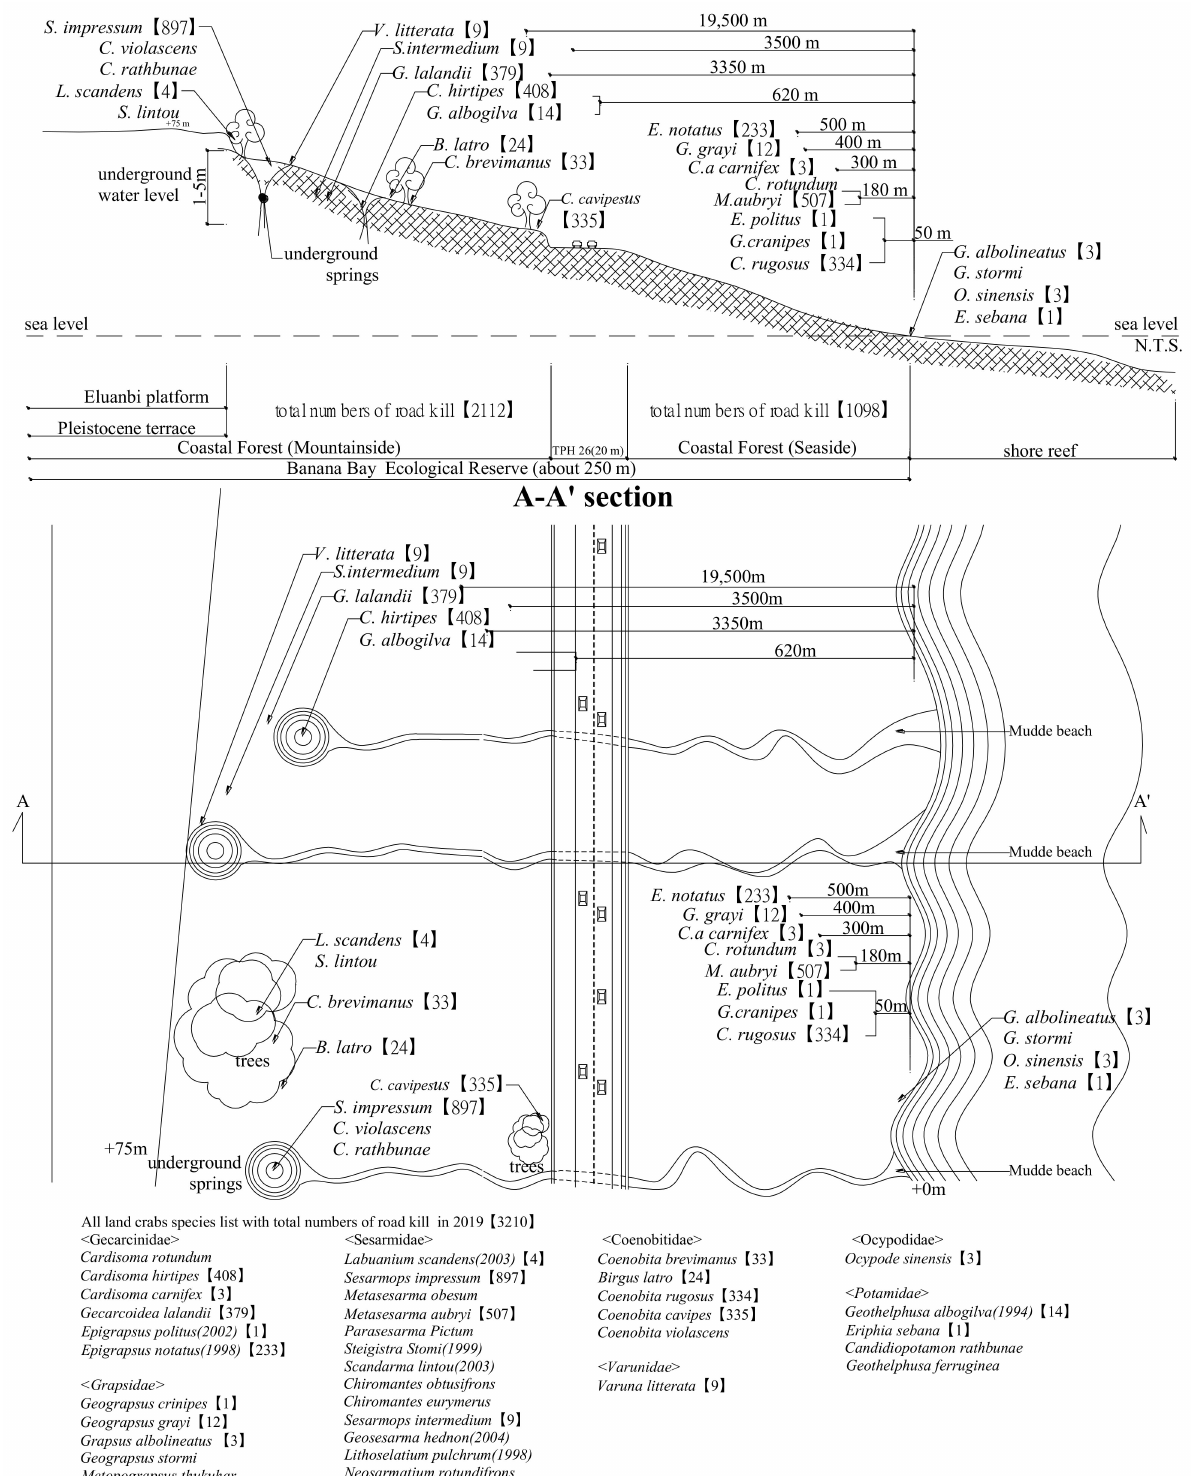
Figure 7. The living environment of 24 land crab species and road kill numbers in 2019 (Note: data from